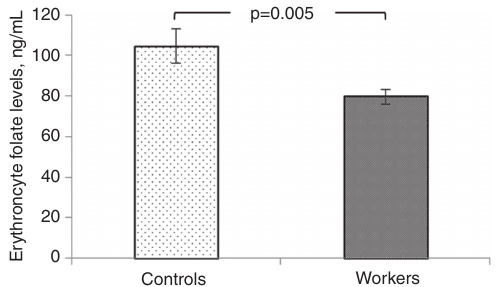
Figure 1 Erythrocyte folate levels of the controls and workers.